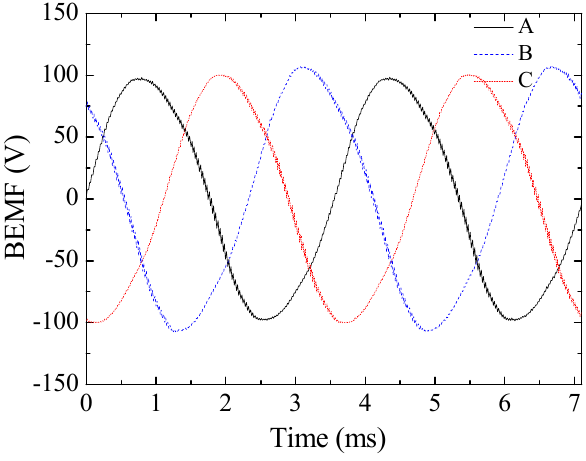
Figure 15. Tested no-load phase BEMFs at rated speed of 2800 rpm.